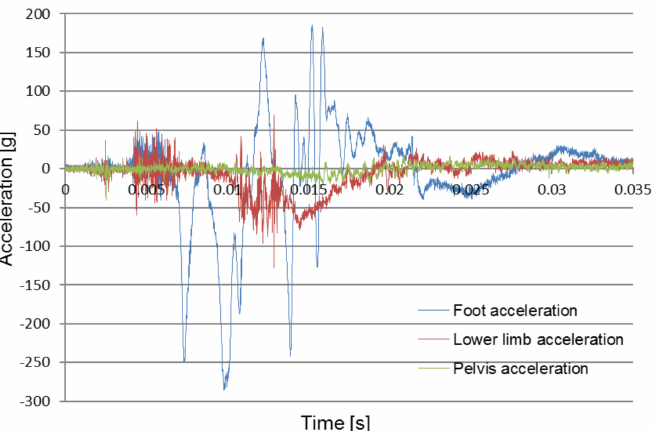
Figure 10. Comparison of recorded signals for pelvic and lower limb acceleration during the first test (B2_P1).